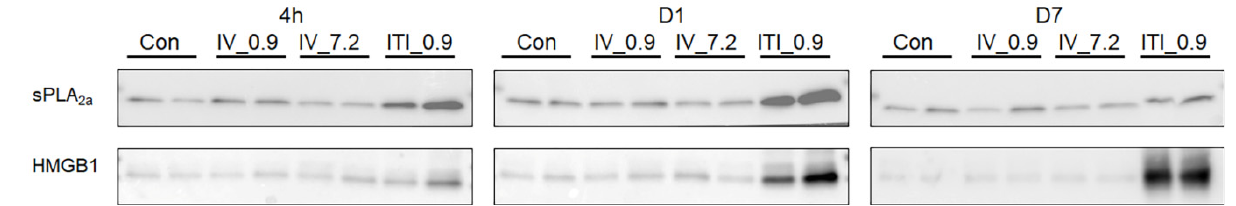
Figure 5. Measurement of HMGB1 and sPLA 2 in the BAL fluid of PHMG-P-treated mice: Mice were intravenously injected with 0.9 mg/kg (IV_0.9) or 7.2 mg/kg of PHMG-P (IV_7.2), or intratracheally instilled with 0.9 mg/kg of PHMG-P (ITI_0.9). Mice were euthanatized at 4 h and days 1 and 7 after exposure. Protein levels of sPLA 2 and HMGB1 in the BAL fluid were measured using Western blotting.